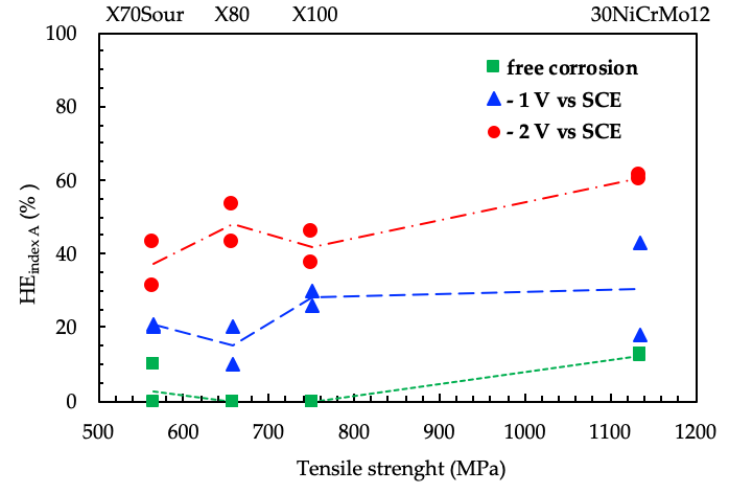
Figure 14. E ff ect of the mechanical properties of the steels on the HE index in SSR tests. Figure 14. Effect of the mechanical properties of the steels on the HE index in SSR tests.